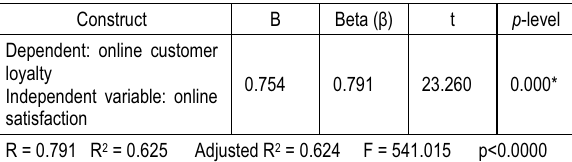
Table 7. Regression analysis: online satisfaction and online customer loyalty Dependent: online customer loyalty